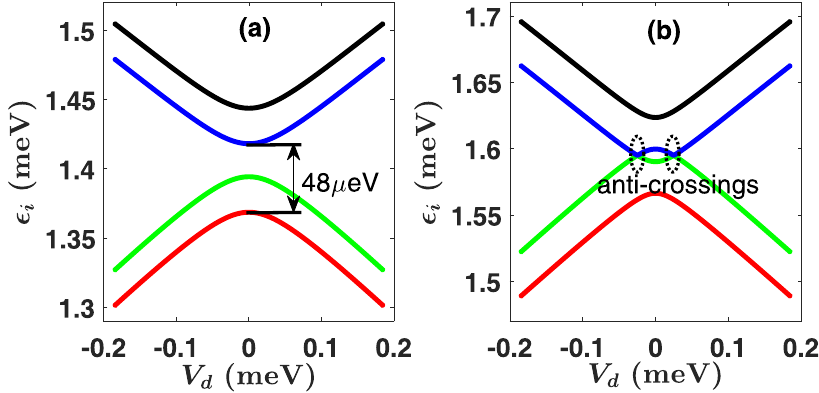
Figure 2. Typical energy diagrams for a DQD. The interdot detuning is given by V d = 2 eEd . The magnetic field is B = 1 T for ( a ) and B = 1.3 T for ( b ). In panel (a), from top to bottom, the black, blue, green, and red lines represent the energy levels of the states ↓ e , , ↑ e , , ↓ g , , and ↑ g , . For B = 1.3 T, when Zeeman energy is larger than the tunnel coupling, the energy of ↑ e , is smaller than the energy of ↓ g , near V d =